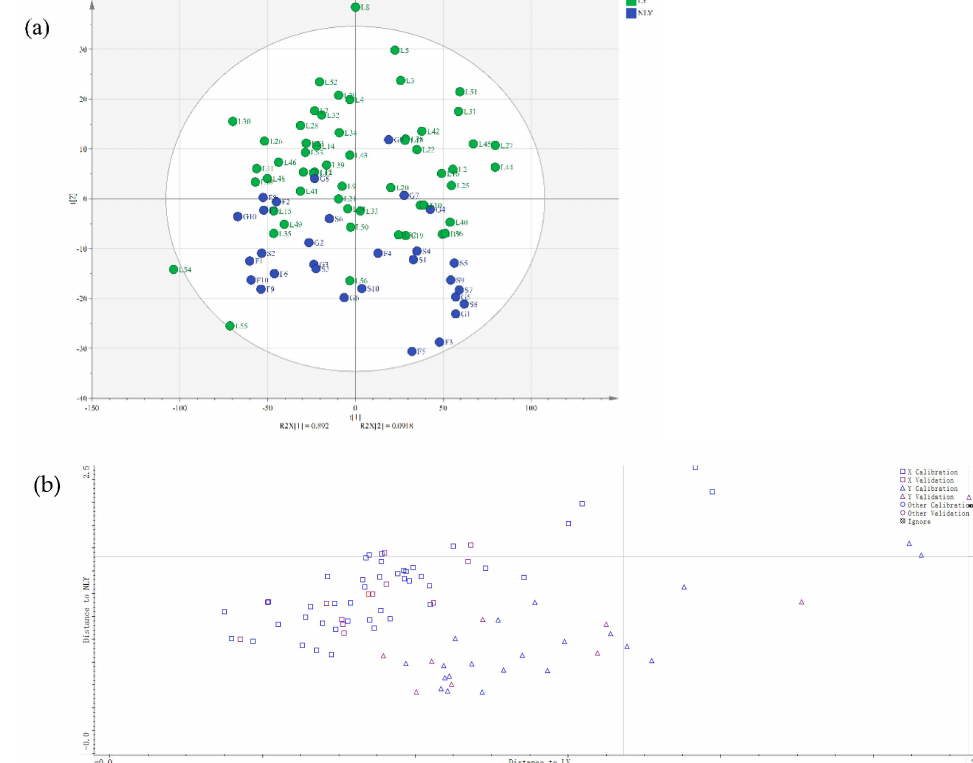
Figure 2. Classification result for Lushan Yunwu tea (LY) and non-Lushan Yunwu tea (NLY) discrimi- nation. ( a ) Principal component analysis (PCA) model (green—LY, blue—NLY); ( b ) discrimination analysis (DA) model with MSC pretreatment in the wavenumber range of 9700–8600, 7400–6800, 5600–4000 cm − 1 ( (cid:3) —LY, (cid:52)